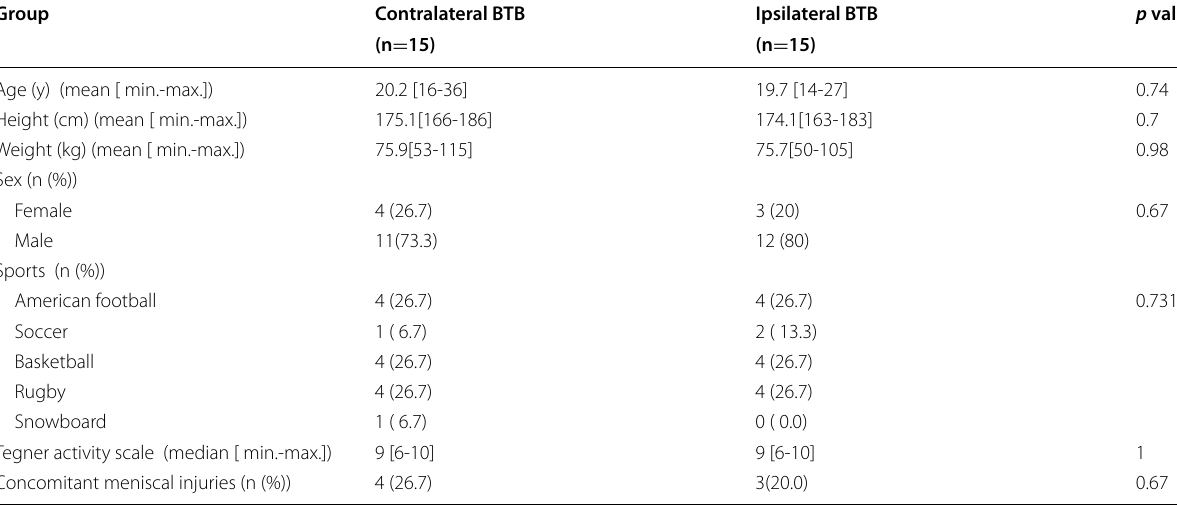
Table 1 Matched patients’ baseline